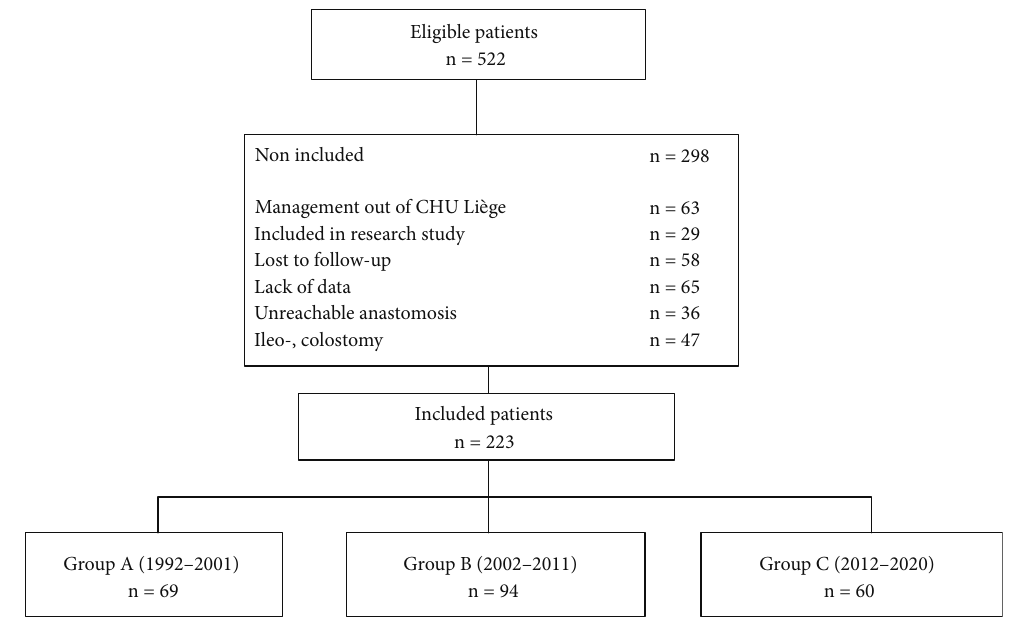
Figure 1: Patients fl ow